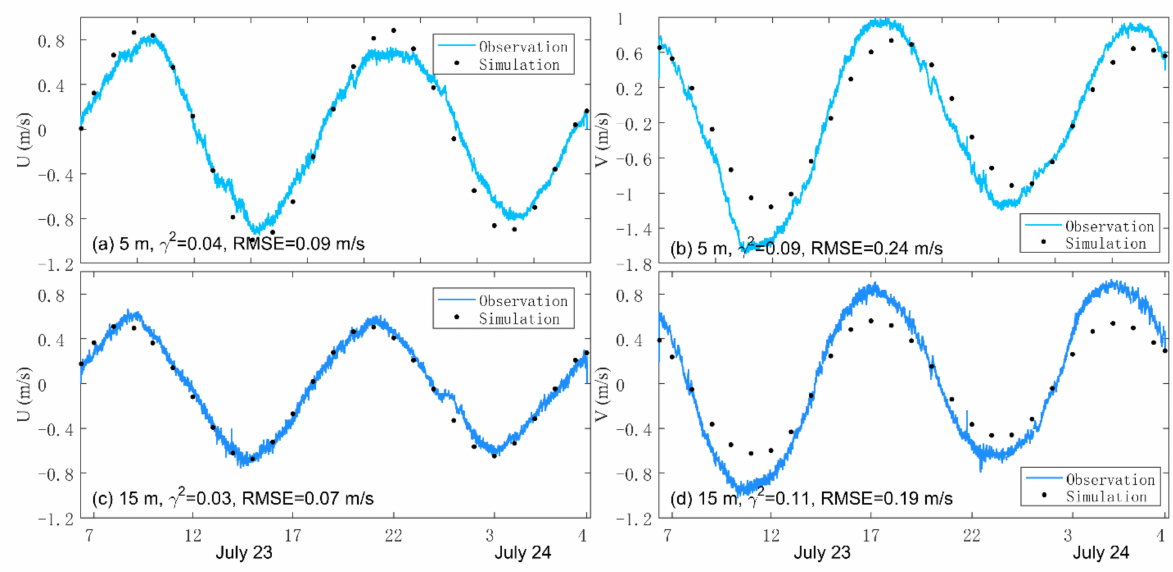
Figure 8. Time series of ( a , c ) east-westward and ( b , d ) north-southward currents at 5 m and 15 m depths at station DD based on in situ observations (lines) made by scientists of Hohai University and simulated currents (black dots) produced by the inner model in case CR on 23 and 24 July 2016 (UTC+8 h). Positive values indicate eastward and northward directions,